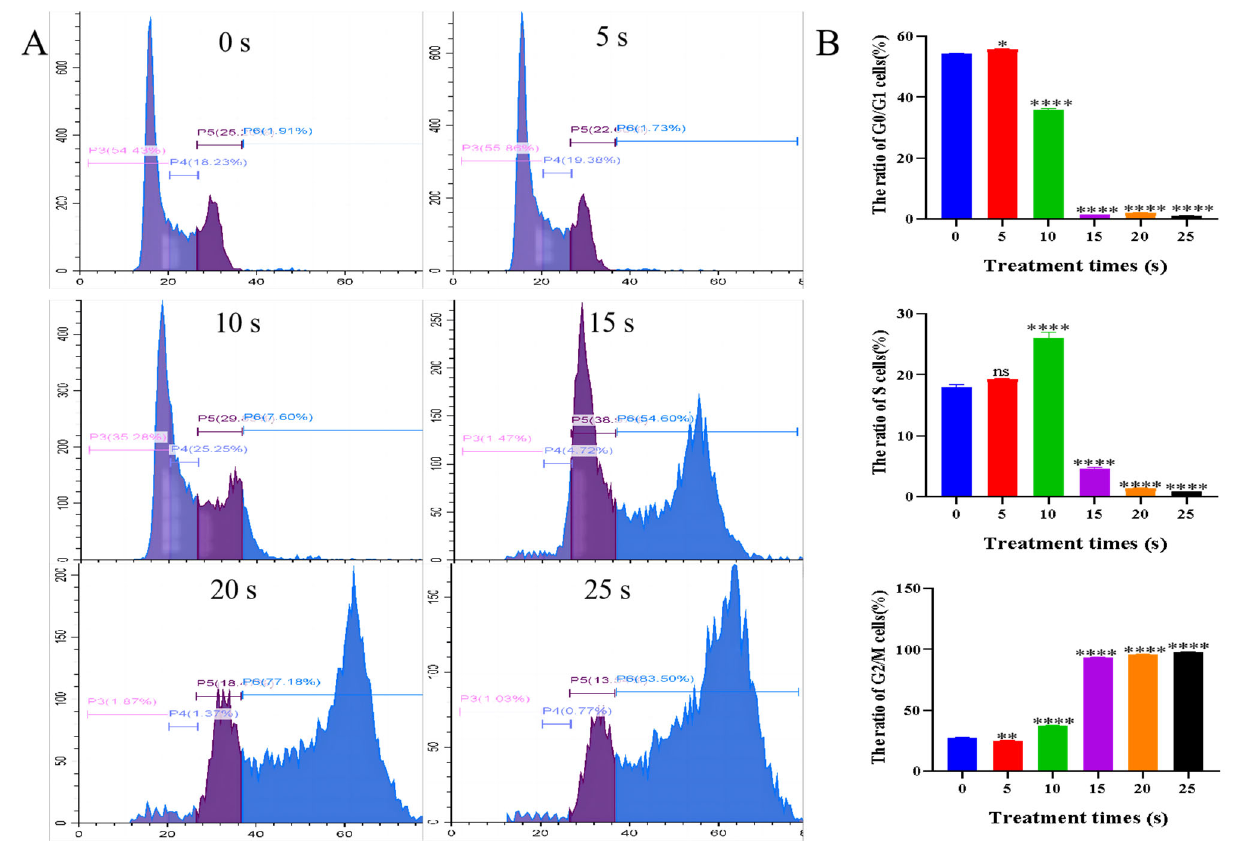
Figure 6. Effect of NTP treatment on HaCaT cell cycle. ( A ) The cell cycle distribution of HaCaT cells after NTP treatment was detected by flow cytometry. ( B ) The cell population at each stage was expressed as a percentage of the total number of cells. Data represent the mean ± SD of three independent experiments. “ns” was not considered statistically significant. * p < 0.05, ** p < 0.001, **** p < 0.0001 with ANOVA compared with the control.